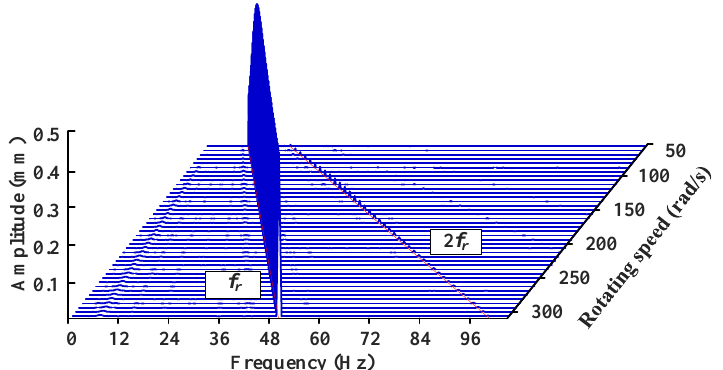
Figure 3. The waterfall diagram of the rotor system in x -direction. As shown in Figure 2, the critical speed of the rotor system is 144.5 rad/s, and then the system output characteristic is considered under different rotating speeds (low speed, critical speed, and overcritical speed), and the results of amplitude in the time domain and the corresponding frequency spectra of signals are calculated, as shown in Figures 4 – 6.